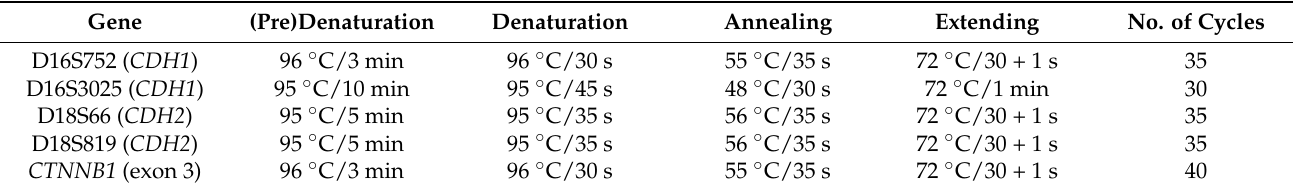
Table 1. Polymerase chain reaction conditions for amplification of CDH1 and CDH2 microsatellite markers and exon 3 of the CTNNB1